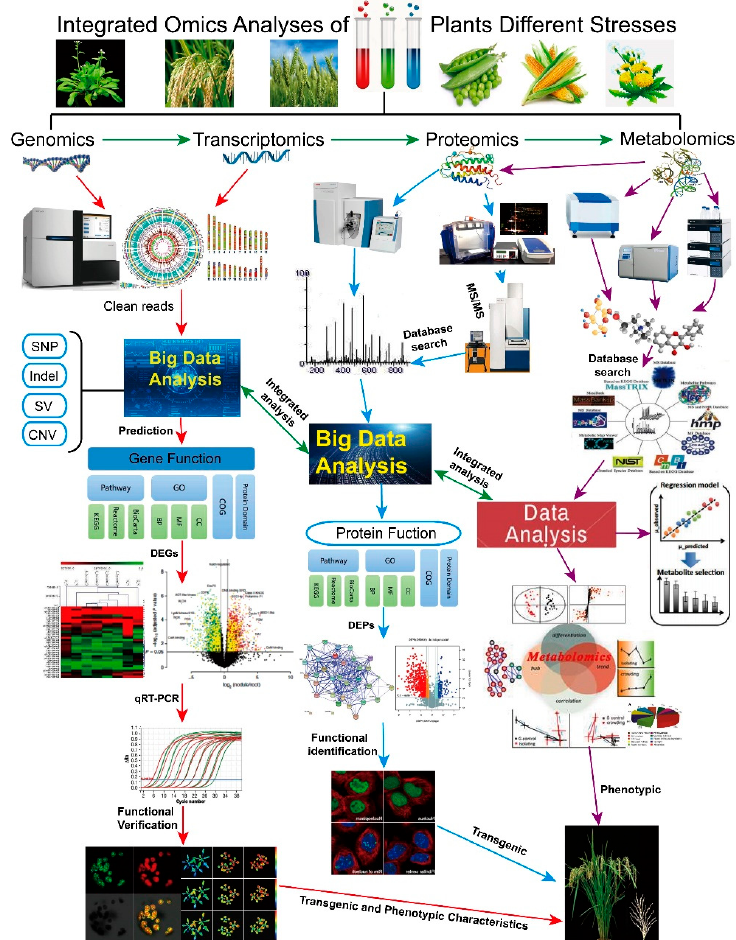
Figure 1. Integrated omics analyses of plants under different stresses. On the basis of the high-quality genomic data, integrated analyses using transcriptomic, proteomic, metabolomics, and phenomic methods have recently been performed in different plant species under different biotic and abiotic stressed conditions to determine their stress responsive genes and proteins, after which functional analyses of these target genes and proteins are conducted by molecular and biochemical methods. These integrated data have provided a deeper understanding of how plants grow and survive under di ff erent